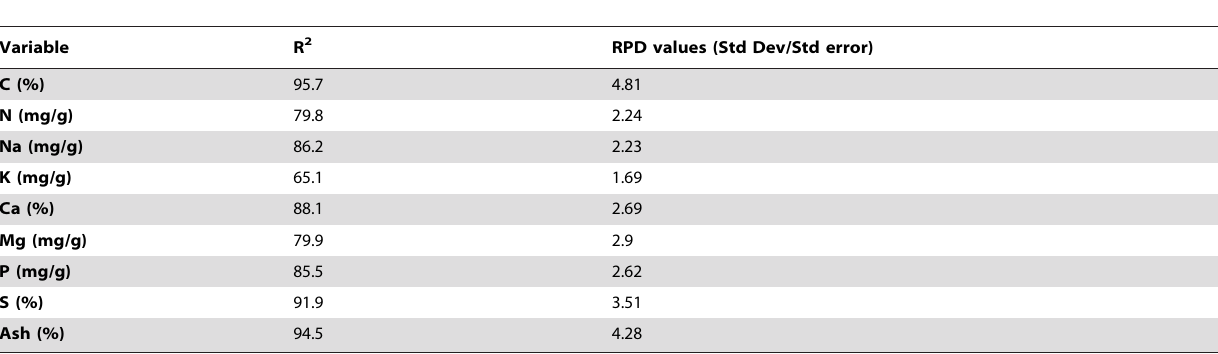
Table 4. Results of PLS regression analyses between FTIR spectra and the C (%), N (mg/g), C/N, Na (mg/g), K (mg/g), Ca (%), Mg (mg/g), P (mg/g), S (%) and Ash (%) concentrations of the samples analysed.